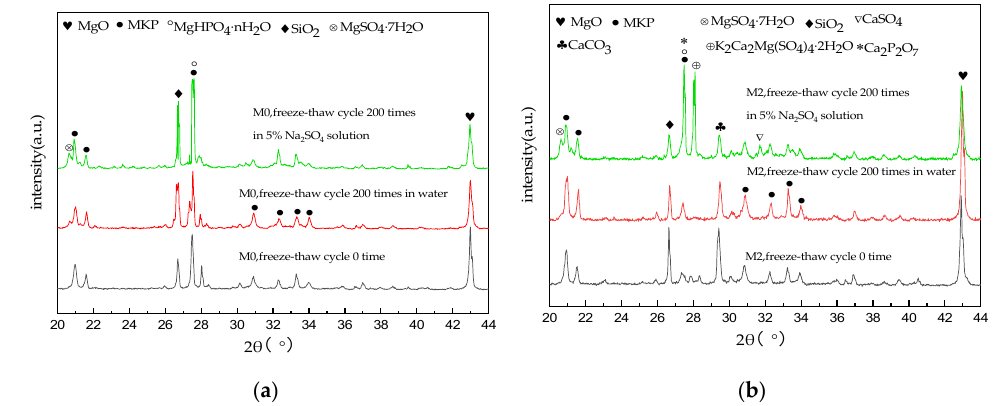
Figure 5. XRD diffractograms of MKPC samples ( a ) M0 and ( b ) M2.